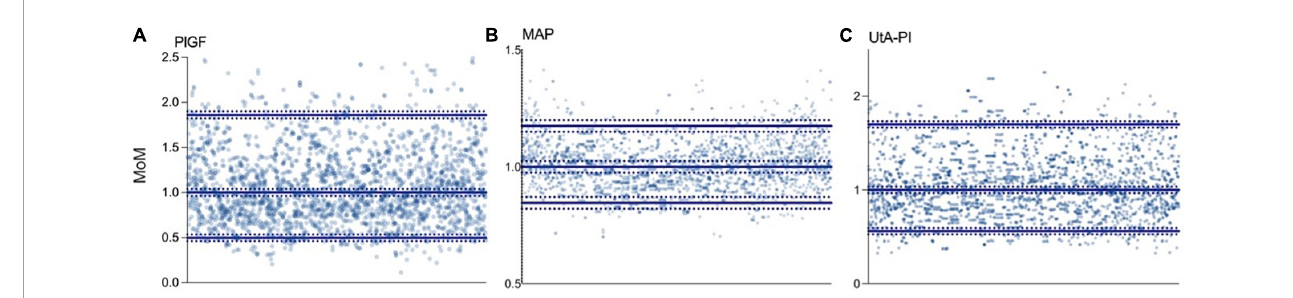
FIGURE2 Distribution of biomarkers in the control group. (A) Placental growth factor (PlGF): median 1.000 (95% CI, 0.989–1.024), p5 0.498 (95% CI, 0.481–0.514), and p95 1.861 (95% CI, 1.843–1.877). (B) Mean arterial pressure (MAP): median 1.000 (95% CI, 0.962–1.039), p5 0.846 (95% CI, 0.807–0.884), and p95